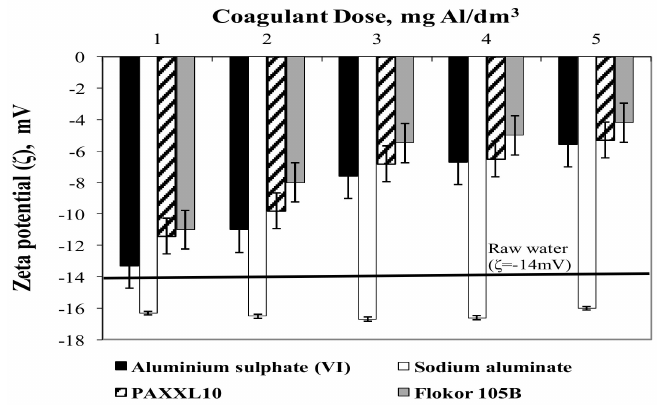
Figure 6. The e ff ect of the type and dose of a coagulant on the change in Zeta potential in the